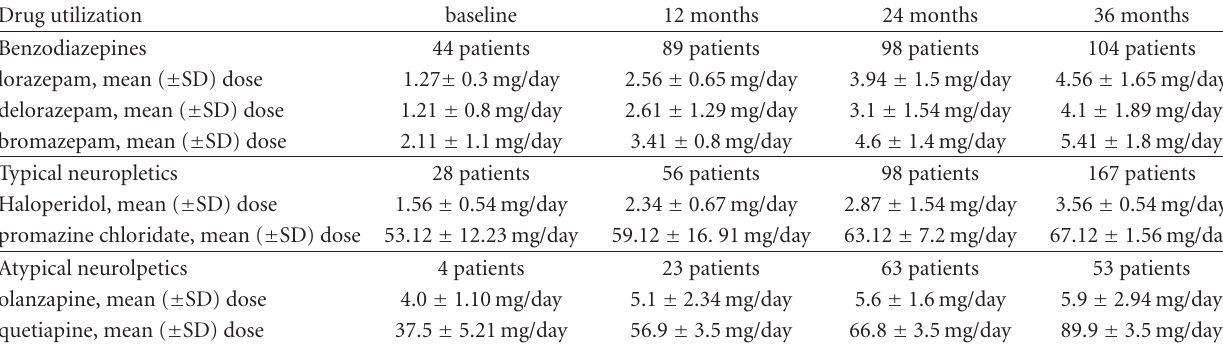
Table 3: A synopsis of the SNC drugs employed by the